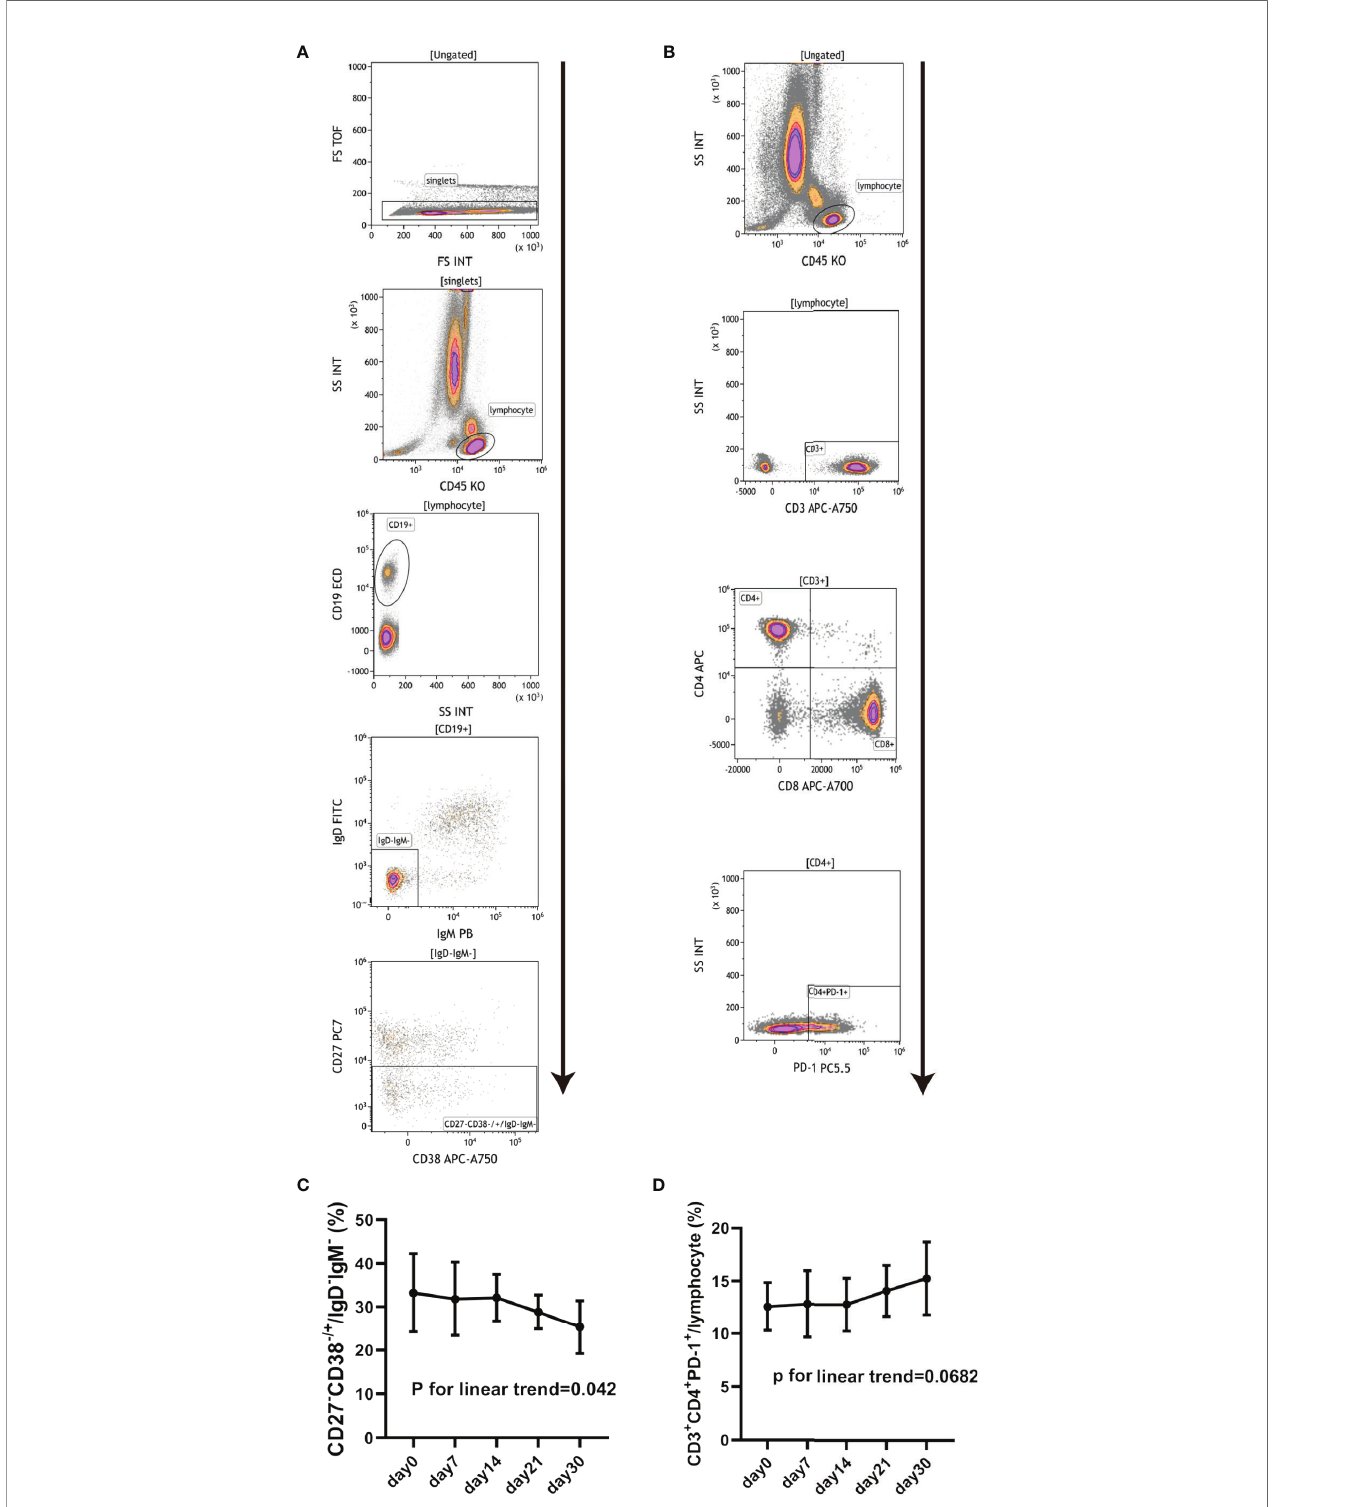
FIGURE 4 | Changes in peripheral blood lymphocyte subsets in cABMR patients after BM-MSCs treatment. Representative fl ow cytometry plots of CD27 - CD38 -/+ / IgD - IgM - (A) and CD3 + CD4 + PD-1 + /lymphocyte (B) . Percentage of CD27 - CD38 -/+ /IgD - IgM - pre and after BM-MSCs treatment in one month (C) . Percentage of CD3 + CD4 + PD-1 + /lymphocyte pre and after BM-MSCs treatment in one month (D) . Points represent mean. Bars represent standard deviation. Data were analyzed by linear trend